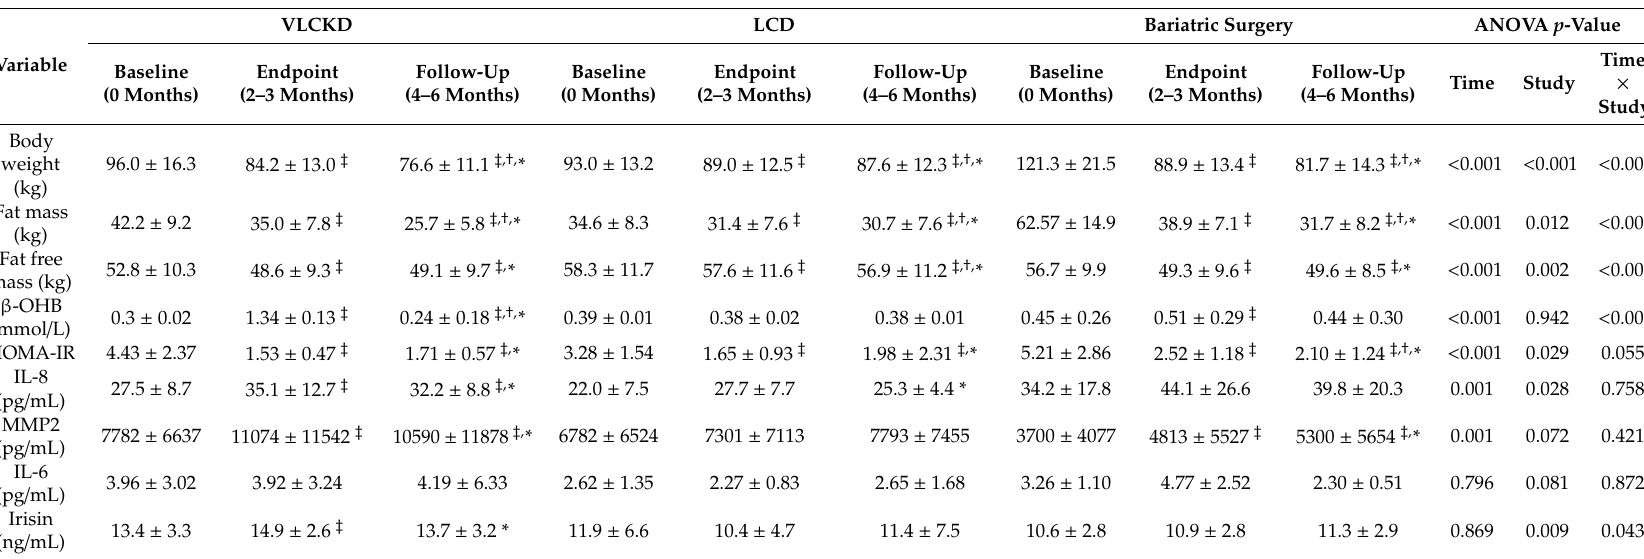
Table 1. Changes induced by the weight loss treatments in body weight, body composition and biochemical